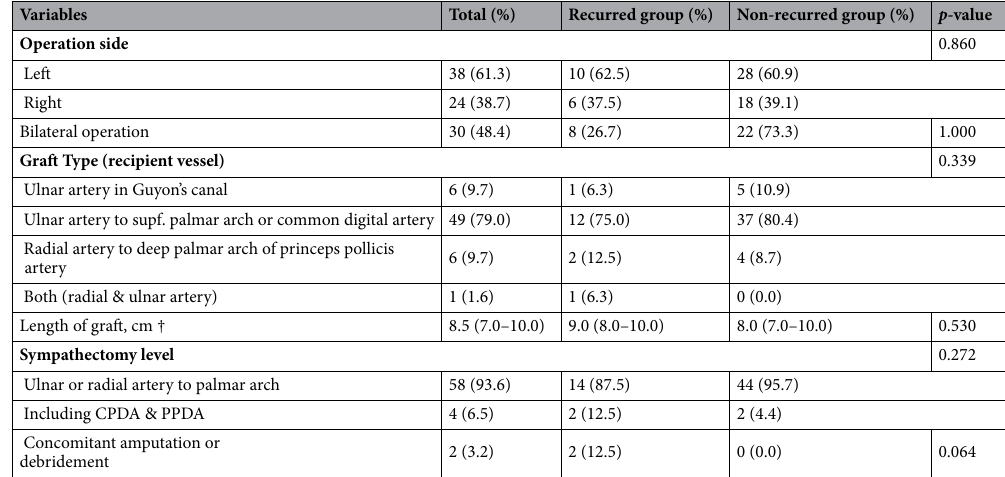
Table 2. Operation-related Variables in the Recurred and Non-recurred Groups. CPDA, common palmar digital artery; PPDA, proper palmar digital artery. † Median (interquartile range).